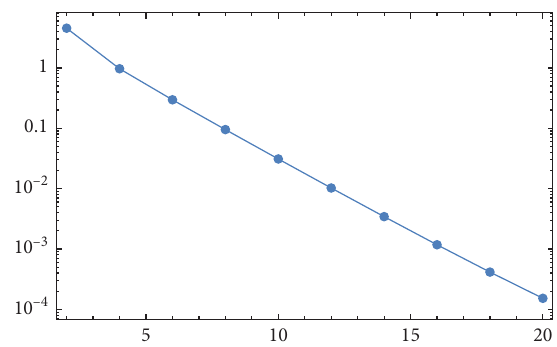
Figure 6: Total residual error via the order of approximation.